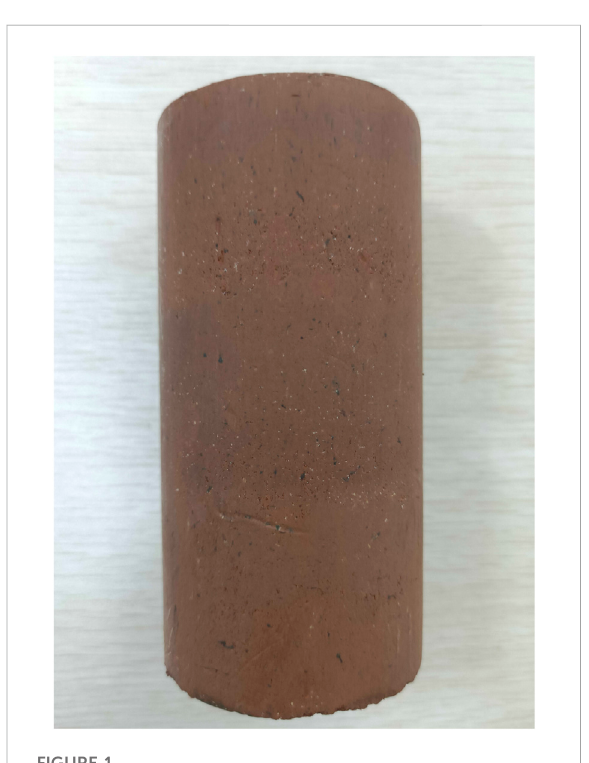
FIGURE 1 Coir fi ber-reinforced soil with a diameter of 61.9 mm and height of 125 mm.